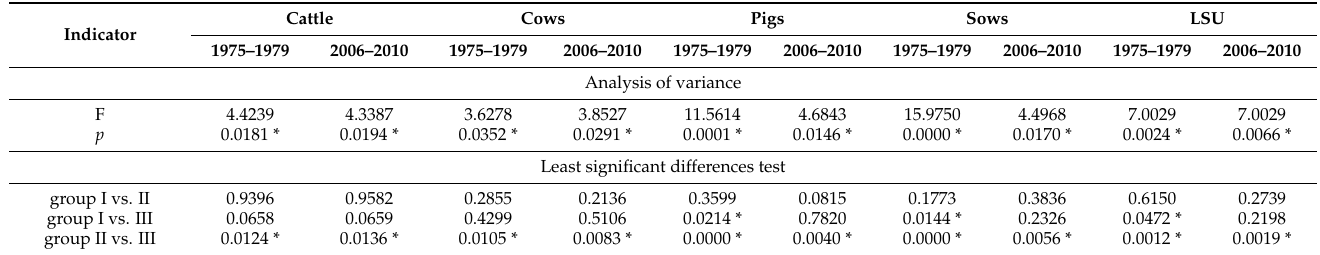
Table 7. Results of the analysis of variance regarding the significance of the differences in livestock for individual voivodships at the beginning and the end of the analyzed period (average for five years).